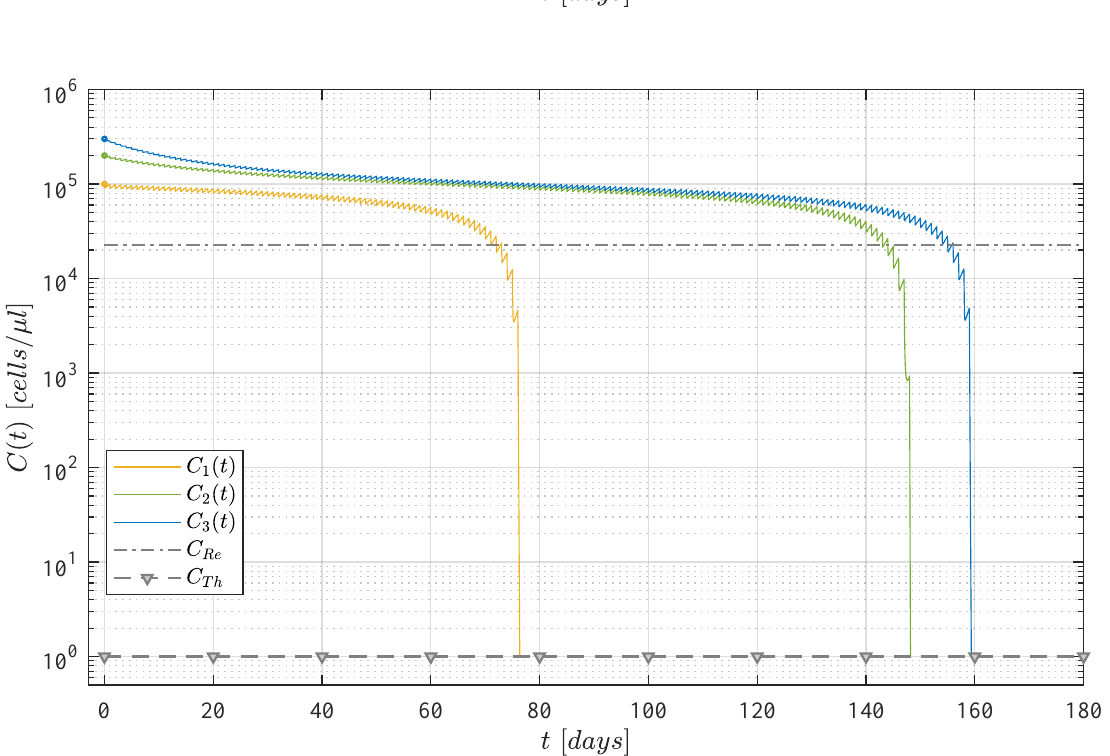
Figure 6. Dynamics of solutions of the CML cancer cells population [ C ( t )] when considering three initial tumour C max = 1 × 10 5 cells/ µ L, C 2 ( t ) with C ( 0 ) = 2 C max = 2 × 10 5 cells/ µ L, and C 3 ( t ) with sizes: C 1 ( t ) with C ( 0 ) = 1 3 3 C ( 0 ) = C max = 3 × 10 5 cells/ µ L. Regardless of the initial tumour concentration, complete leukemia cells eradication is achieved in all cases. The immunotherapy administration protocol from Figure 2 is applied to each case, i.e., daily applica- tions of the treatment with a duty cycle of 45min/day ( 3.1% ) and a fixed amplitude of φ i = 1.01 × φ inf = 15,396 cells/ µ